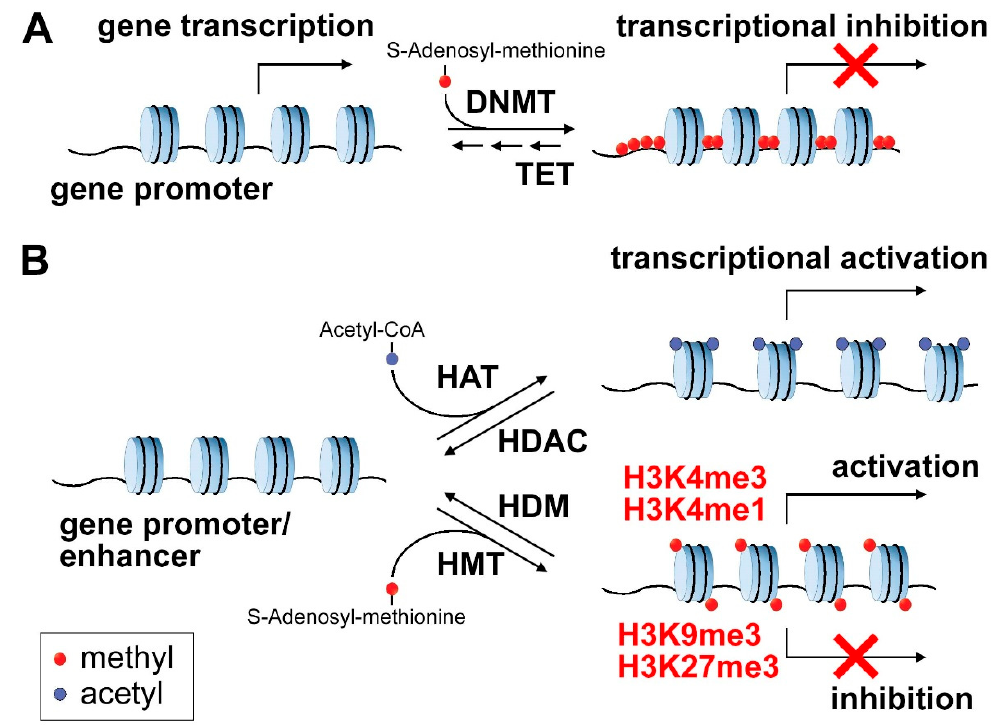
Figure 1. Epigenetic regulation of gene expression. ( A ) DNA methylation on gene promoters causes transcriptional inhibition through compaction of chromatin. ( B ) Histone modifications can occur on gene promoters or enhancers and can cause gene activation or repression: acetylation is associated with gene activation, methylation can be associated with either activation or repression according to the methylated residue, as indicated.